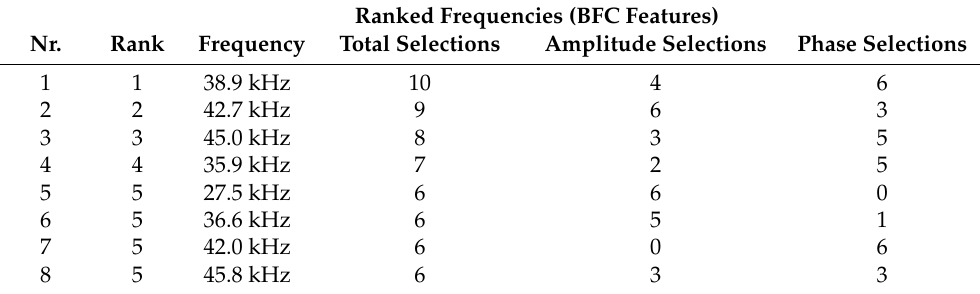
Table 6. Ranked BFC features, i.e., frequencies, for transducer combinations 4 and 9 with their rank, total selections, amplitude selections, and phase selections. Ranking is based on how often the respective frequency is selected either as an amplitude or a phase feature in the six different LOGOCV models. Four frequencies are selected six times each.